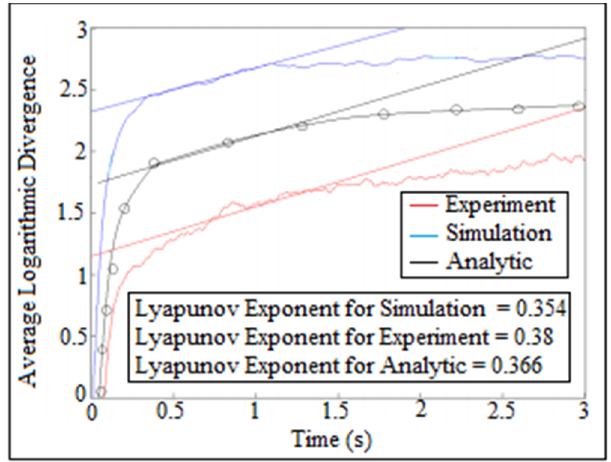
Figure 23. Average logarithmic divergence against the time for (I.D. = 16 mm) and (N = 200 rpm).